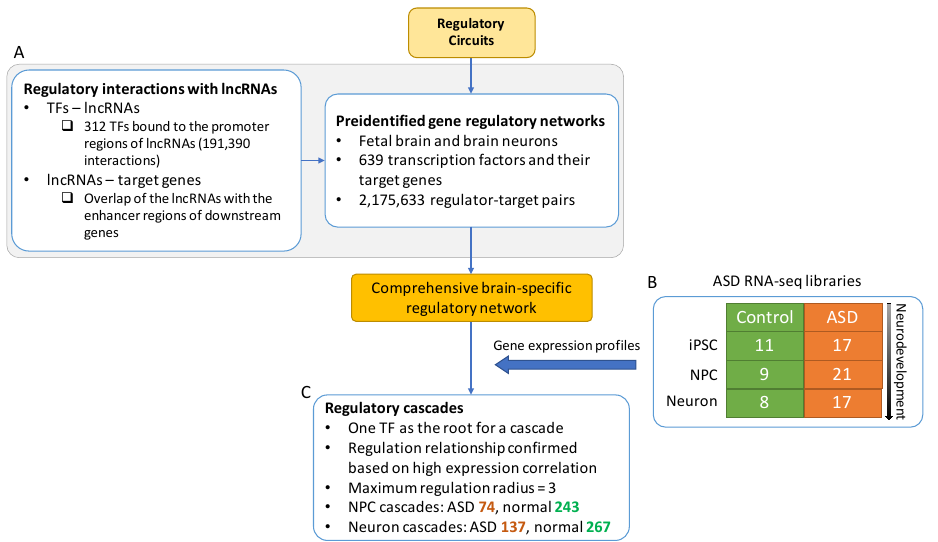
Figure 3. The workflow of generating gene regulatory cascades. The gene regulatory networks of fetal brain and brain neuron tissues were created based on Regulatory Circuits [18] and lncRNAs were incorporated to complete the regulatory networks ( A ). The gene expression profiles ( B ) of ASD were overlaid on the network to establish ASD regulatory cascades ( C ). The root of each regulatory cascade is a